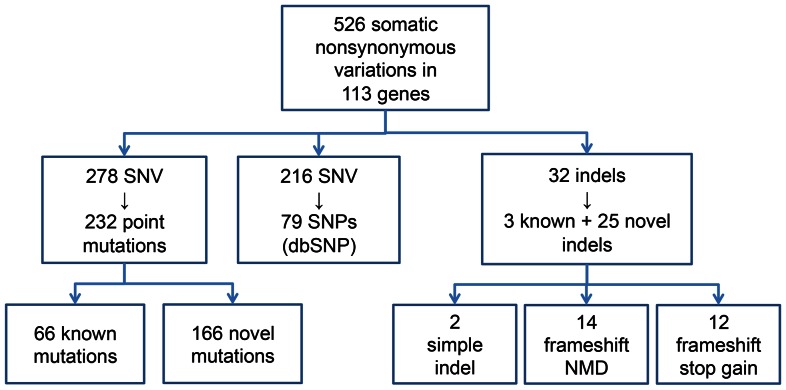
Summary of mutations.SNV, single nucleotide variation; SNP, single nucleotide polymorphism; NMD, non-sense mediated decay.